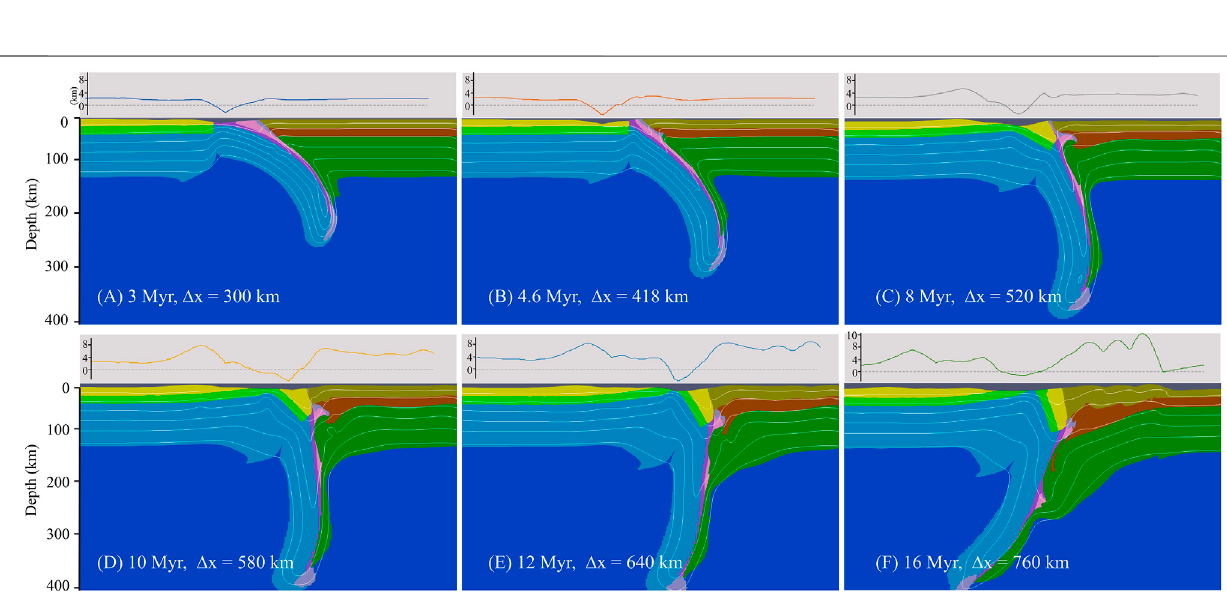
Frontiers in Earth Science |